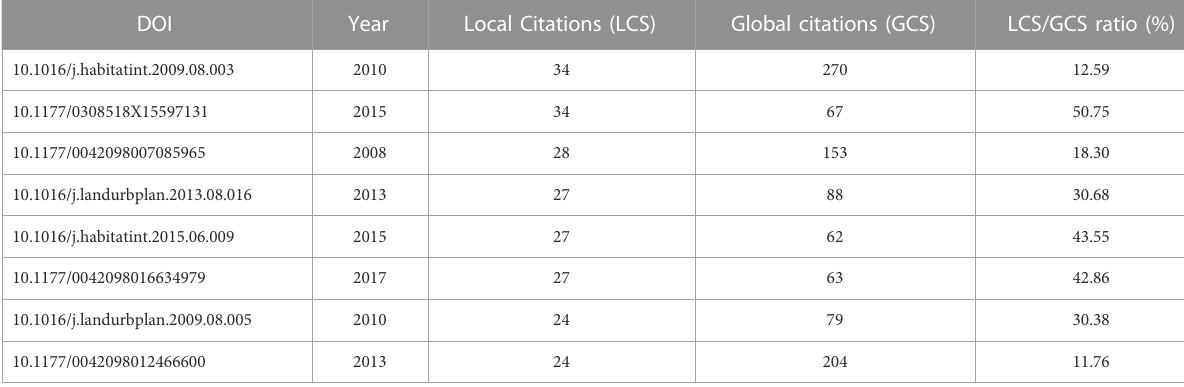
TABLE 2 Top 10 journals with local citation in the fi eld of rural